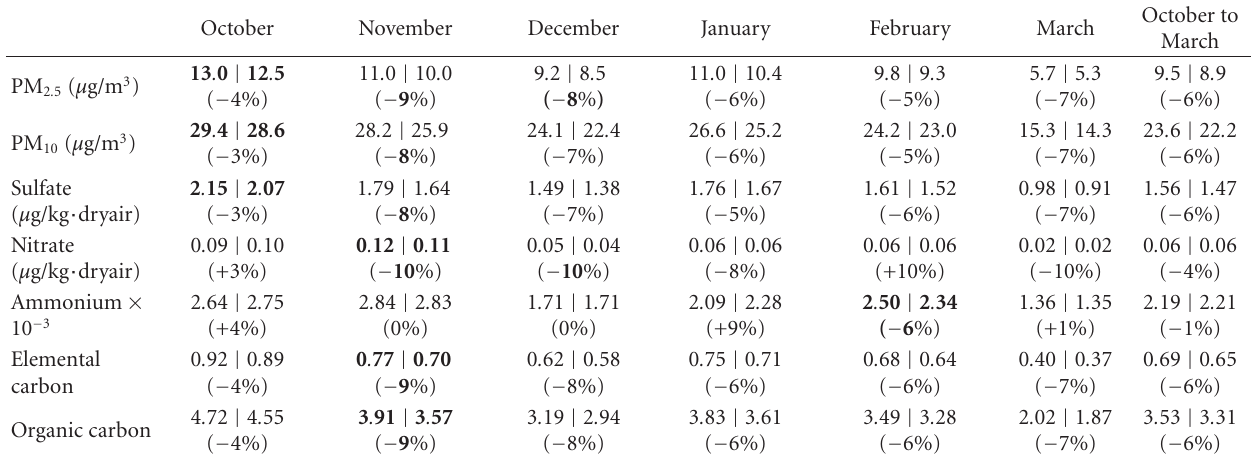
Table 2: Monthly mean of 24h-averaged PM 2 . 5 , PM 10 , sulfate, and nitrate concentrations in the nonattainment area as obtained with REF (first value) and LSF (second value) and percent change (in brackets). Reductions are presented negative. Bold values indicate significant